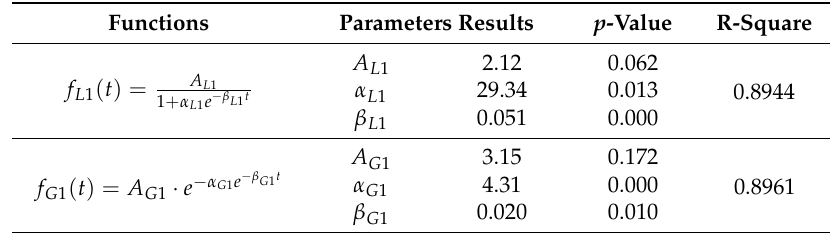
Table 2. The regression results of the parameters of timber volume growth of Pistacia Chinensis .